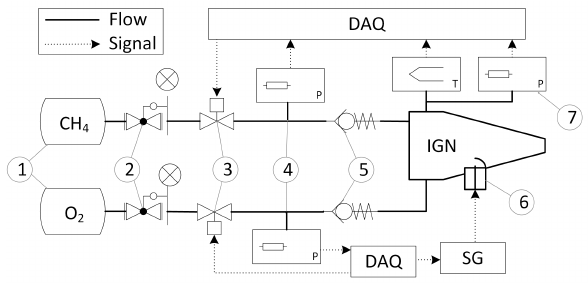
Figure 3. Ignition system